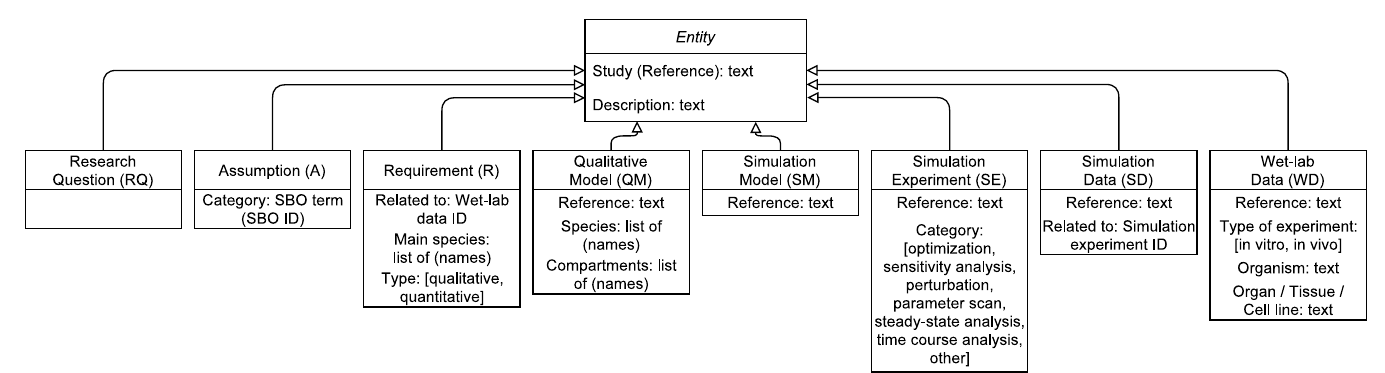
Fig 2. UML class diagram of provenance entities in WebProv . We have identified the following entities to be useful for providing provenance information from simulation studies in the field of systems biology: Research Question, Assumption, Requirement, Qualitative Model, Simulation Model, Simulation Experiment, Simulation Data, and Wet-lab Data. The requested information for each entity type is kept minimal for demonstration purposes and can easily be extended. The Study (Reference) contains information of the publication, for instance, “Lee et al. (2003)” and determines which study an entity belongs to. The Description contains a brief explanation of a particular entity and may be a cited text from the publication. Furthermore, entity references should ideally consist of a digital object identifier (DOI) to make the artifact associated with the particular entity unambiguously accessible. Additional information can always be entered in the “Further Information” part of WebProv .